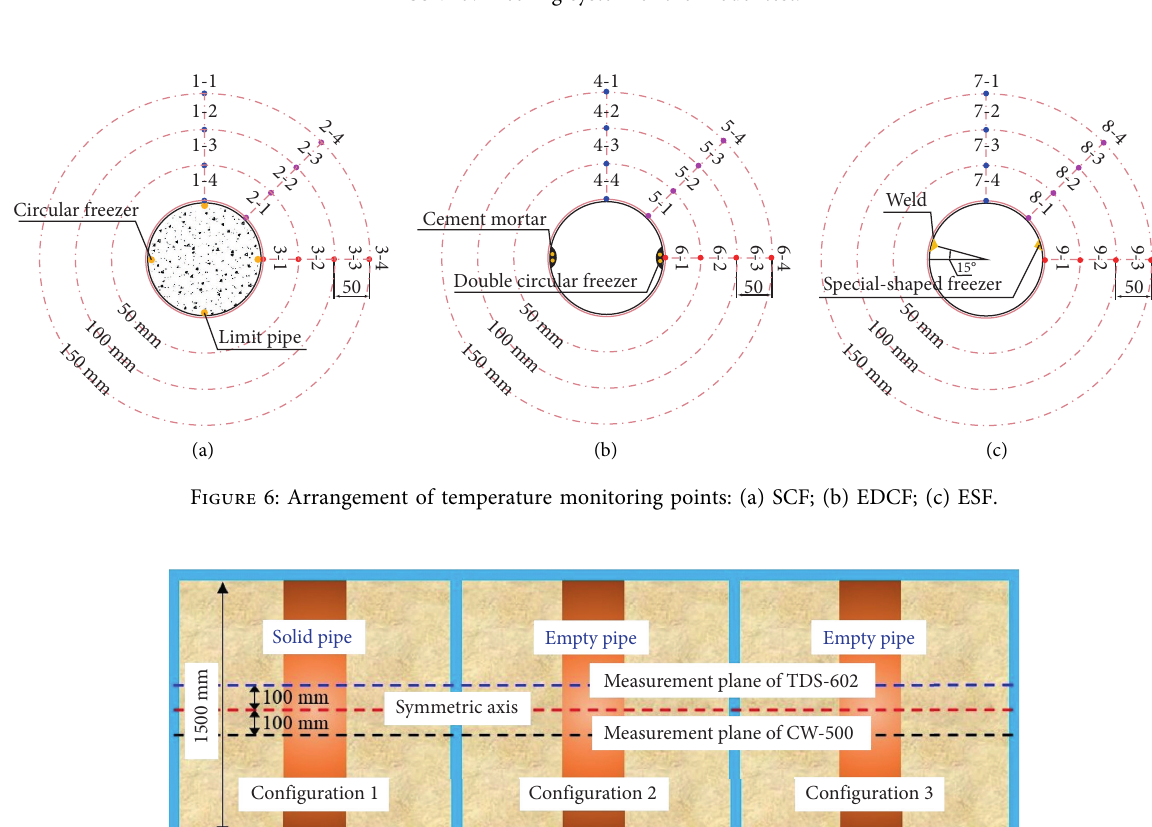
Figure 5: Freezing system of the model test.